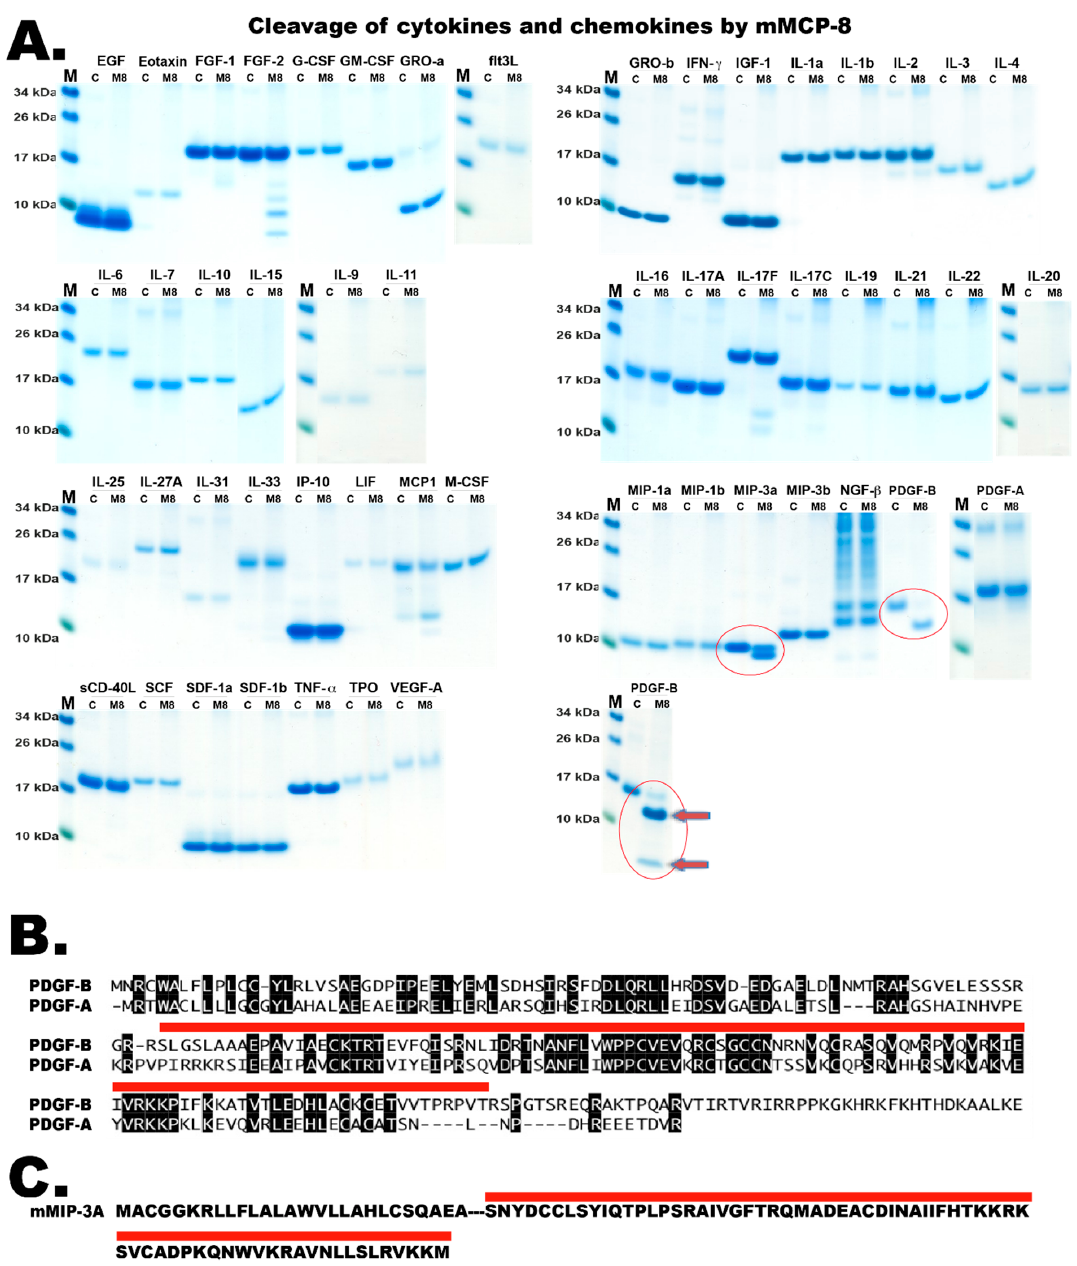
Figure 4. Cleavage of cytokines and chemokines by mMCP-8. Panel ( A ) shows the activity of recombinant mMCP-8 on a panel of 52 different recombinant mouse cytokines and chemokines. The name of the different cytokines and chemokines are listed above each lane, with one control sample without enzyme and one with mMCP-8. The cleavage was performed at 37 °C for two and a half hours after which sample buffer was added and the sample was separated on 4–12% gradient gels. Only two of these cytokines/chemokines (MIP-3a and PDGF-B) were cleaved by mMCP-8. These two panels are marked with red circles. One additional panel with the cleavage of PDGF-B is presented where the gel was run a shorter time to also visualize the second shorter band generated after cleavage. This panel is also marked with a red circle and two arrows pointing at the cleavage products generated by mMCP-8 cleavage. MIP-3a is cleaved close to its N or C-terminal ends whereas PDGF-B is cleaved further into the protein. Panel ( B ) shows a sequence comparison between mouse PDGF-A and PDGF-B using the DNASTAR program and Megaline. All amino acid residues identical between the two proteins are marked with a black background. The red line marks the sequence of the active fully processed mouse PDGF-B. Panel ( C ) shows the amino acid sequence of mouse MIP-3a. The red line marks the sequence of the active fully processed mouse MIP-3a.